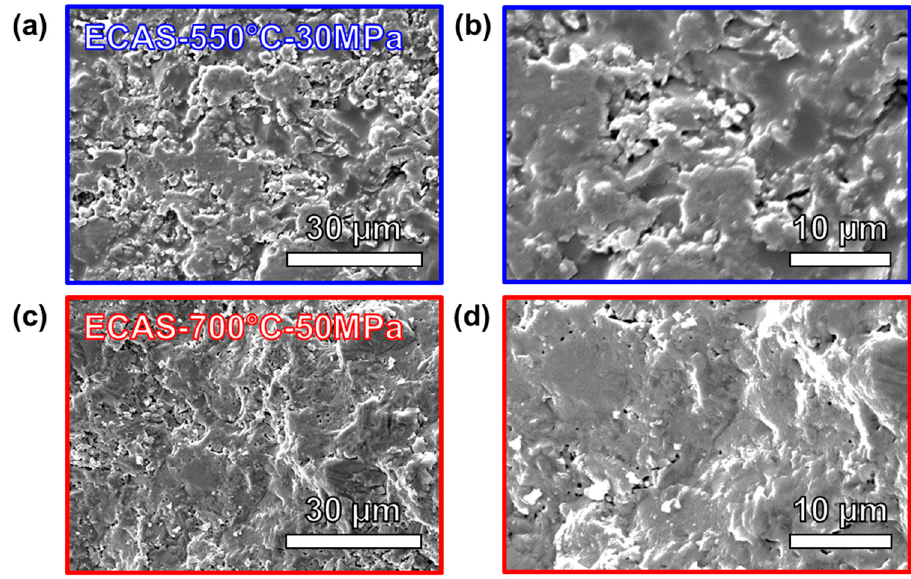
Figure 4. Fracture surface of ( a , b ) ECAS-550 °C-30 MPa and ( c , d ) ECAS-700 °C-50 MPa.